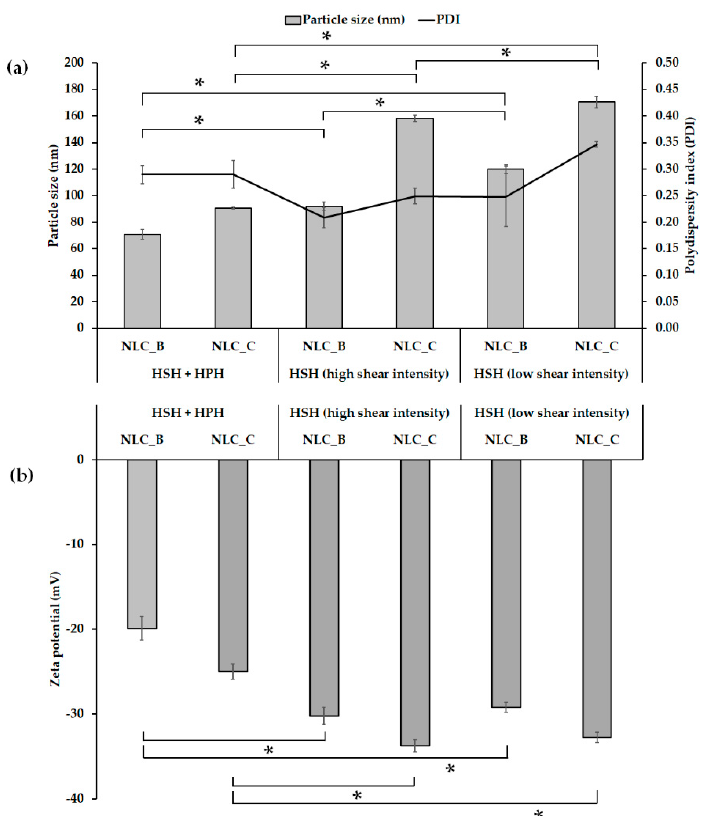
Figure 1. Influence of techniques for nanostructured lipid carriers (NLC) fabrication on ( a ) the particle size and size distribution (PDI) and ( b ) zeta potential. The techniques included (1) a combination of high-shear homogenization (HSH) and high-pressure homogenization (HPH), (2) HSH with a high shear intensity, and (3) HSH with a low shear intensity. Abbreviations: NLC_B, blank NLC; NLC_C, chili-extract-loaded NLC. * The particle size and zeta potential values are significantly different ( p < 0.05) between the methods.